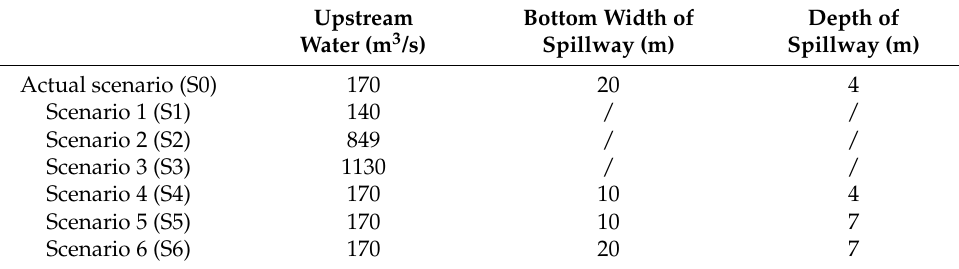
Table 3. Designed scenarios b)